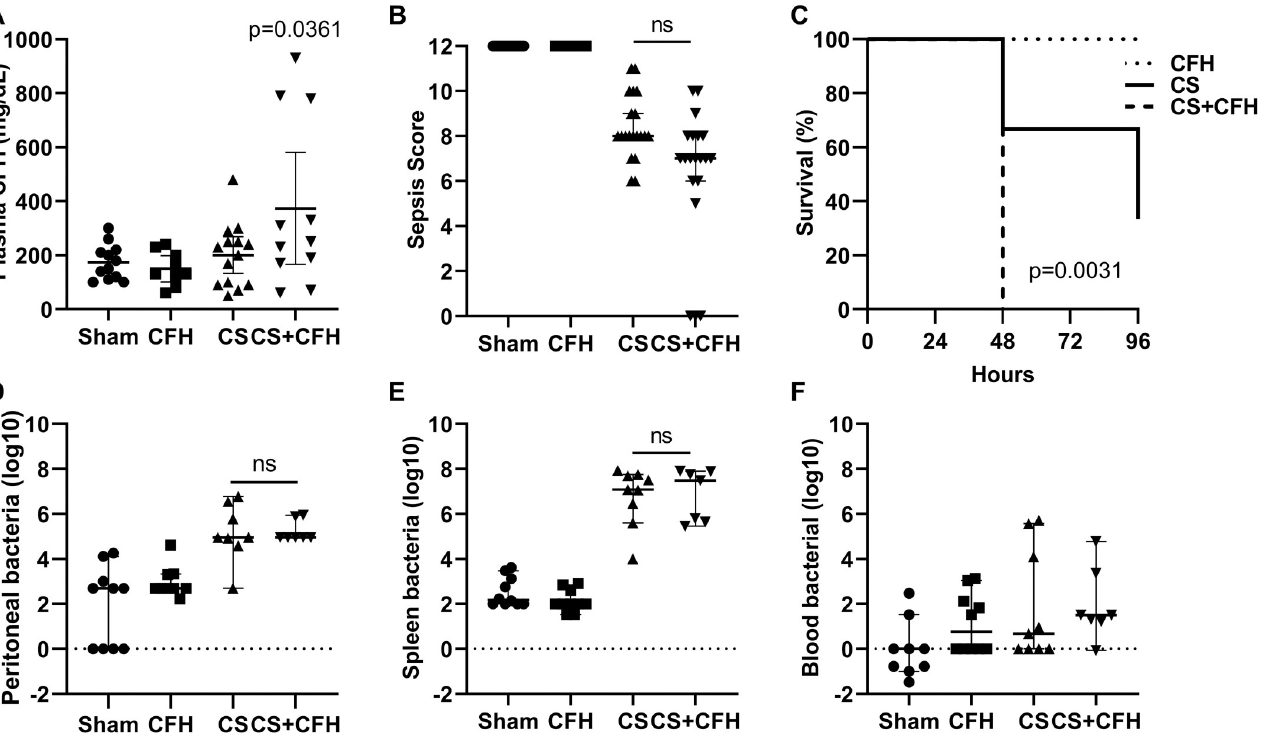
Fig 1. Intravenous CFH augments mortality in sepsis. To establish a clinically relevant model of sepsis with elevated circulating cell-free hemoglobin (CFH), we treated mice with an intravenous (IV) injection of CFH, an intraperitoneal (IP) injection of CS, simultaneous IV CFH and IP CS, or sham IV and IP injections. (A) After 24 hours, the CS+CFH group had the highest circulating CFH levels (n = 9–14, p = 0.0361 vs. Sham). The CS+CFH group had a (B) slightly lower sepsis score indicating more severe illness (n = 20–24, p = ns vs. CS) and (C) lower survival (n = 3–7, p = 0.0031). Bacterial counts measured in (D) peritoneal wash, (E) spleen homogenates and (F) blood were elevated in both CS and CS+CFH groups but did not differ between these two groups (n = 7–10).